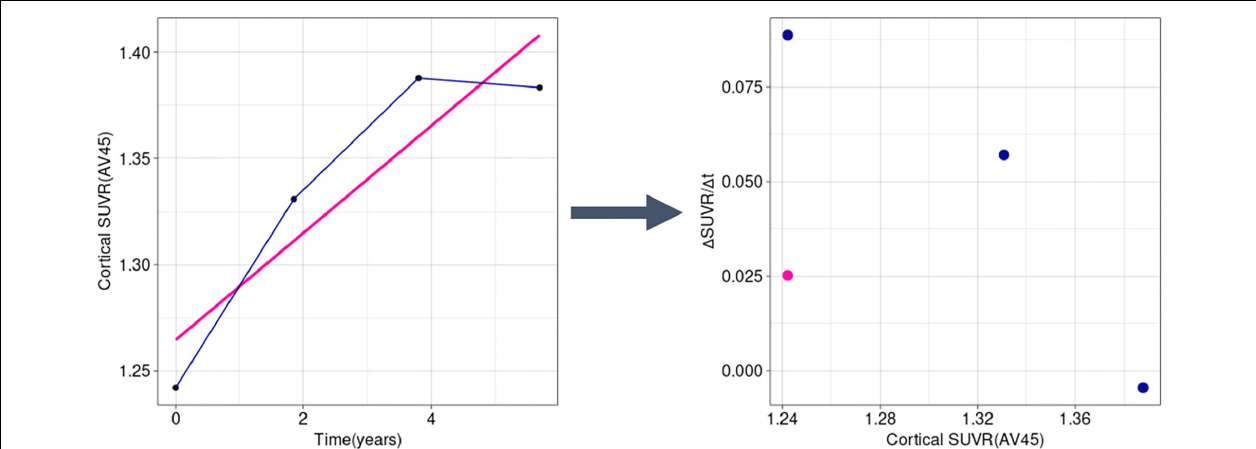
FIGURE 2 | Example transformation of longitudinal SUVR data into (cid:49) SUVR/ (cid:49) t values in a sample subject (RID: 545). Instead of using a single mean slope value (the pink line and dot), we used all observations separately (dark blue lines and dots), accounting for the change of rate over time. SUVR, standardized uptake value ratio.